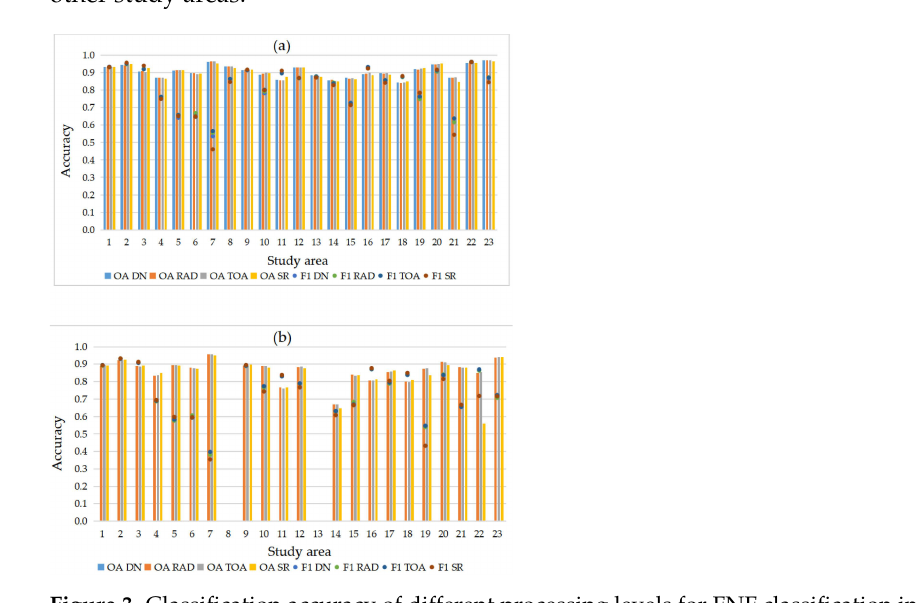
Figure 3. Classification accuracy of different processing levels for FNF classification in each study area, using only the four bands B, G, R, and NIR. ( a , b ) indicate the classification accuracies of GF-1 WFV and L8, respectively. The histogram represents OA, and the scatter plot represents